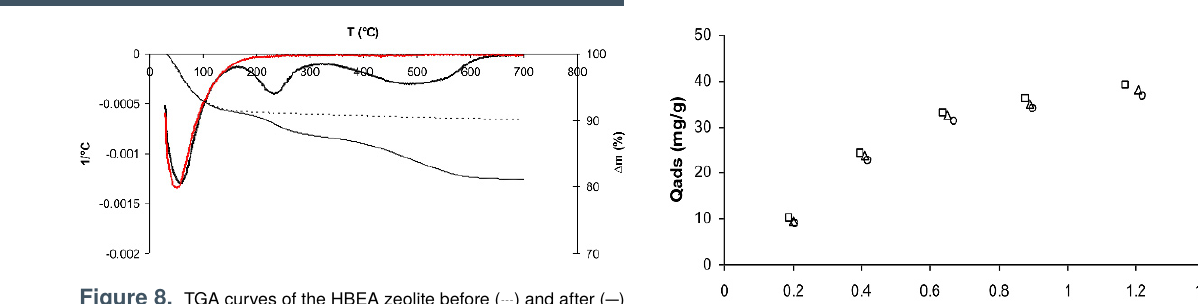
Figure 8. TGA curves of the HBEA zeolite before ( (cid:82) ) and after () adsorption of nitrophenol and derivative weight curves of the HBEA zeolite before (red line) and after (black line) adsorption of nitrophenol. always translates the loss of hydration water. It is clear from the thermogram of the HBEA zeolite after nitrophe- nol adsorption that the two high temperature degradation peaks between 165–600°C are due to the presence of nitro- phenol molecules. The first peak around 235°C represents the beginning of desorption of nitrophenol from HBEA micropores. The second peak around 525°C represents the oxidation of nitrophenol linked to the acid sites in the HBEA zeolite.